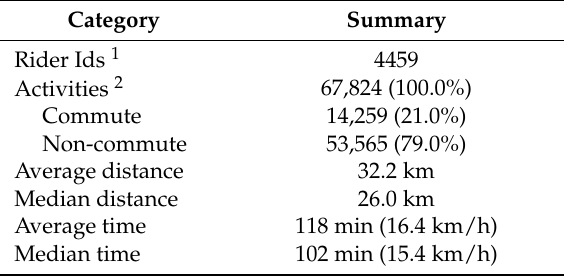
Table 1. Bicycle trip summary within the TxDOT El Paso District.